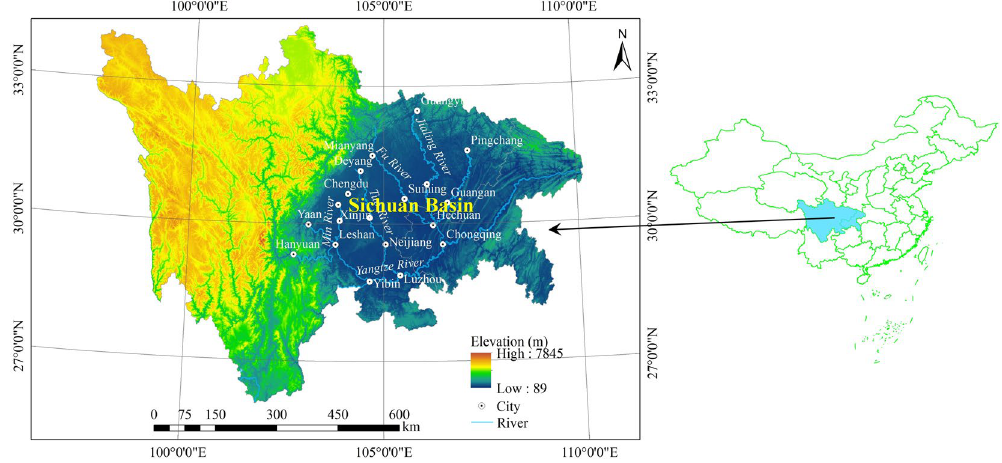
Figure 1. Location of the study